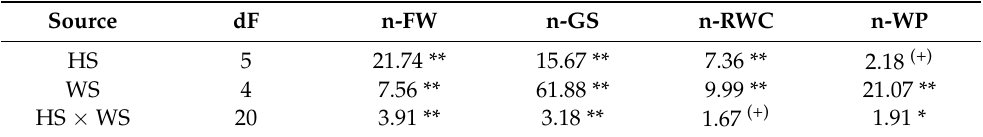
Table 1. F values and statistical significance in the two-way analysis of variance (halophyte species × water salinity levels) carried out on the control-normalized values of the four measured physiological traits: fresh weight (n-FW), stomatal conductance (n-GS), leaf relative water content (n-RWC), and leaf water potential (n-WP). Source dF n-FW n-GS